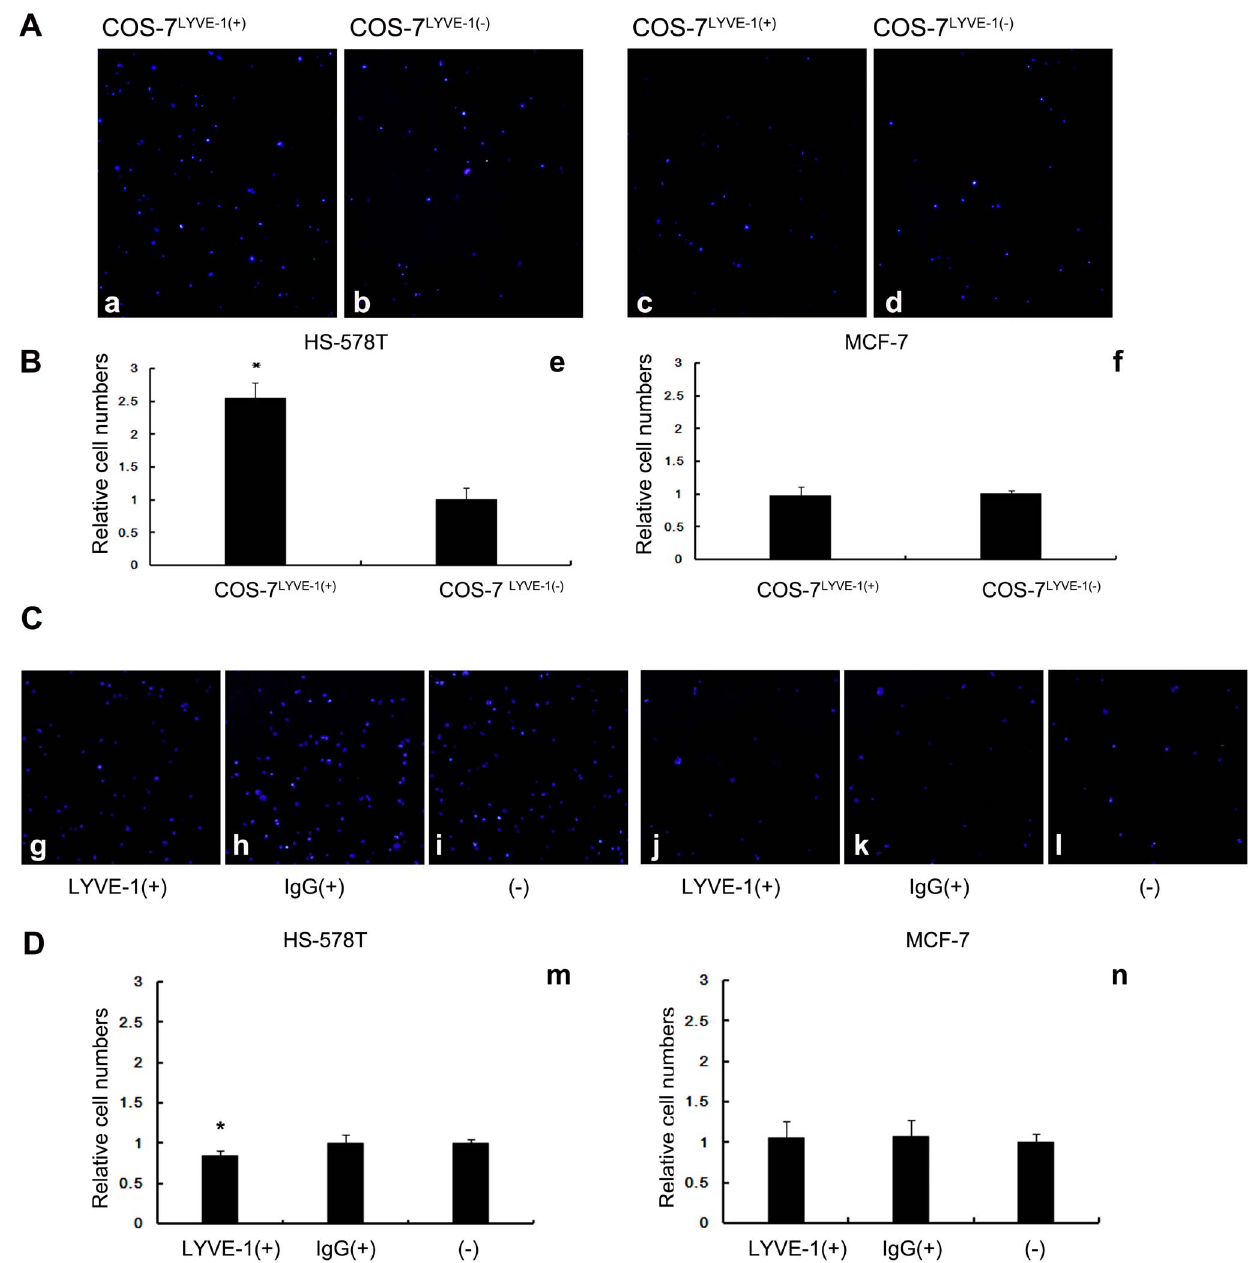
Figure 2. Breast tumor cells expressing high or low levels of HA adhere differently to cells under static conditions. (A) Adhered HS- 578T and MCF-7 cells appear as blue spheres (a–d). DAPI-labeled HS-578T cells were more adherent to the confluent monolayer of COS-7 LYVE-1( + ) cells compared with COS-7 LYVE-1( 2 ) . MCF-7 cells adhered similarly with both COS-7 LYVE-1( + ) and COS-7 LYVE-1( 2 ) cells. (B) Quantitative evaluations of HS-578T and MCF-7 cell adhesion on the monolayer of COS-7 cells are shown, and each assay was performed in triplicate. The results are shown as the mean 6 SD of triplicate wells from a typical experiment and are expressed as a fold increase relative to COS-7 cells transfected with the control vector pEGFP-N1. *P , 0.05 versus indicates transfected pEGFP-N1 vector control COS-7 cells. (C) Adhered HS-578T and MCF-7 cells appear as blue spheres (g–l). DAPI-labeled HS-578T cells were adherent to the confluent monolayer of SVEC4-10 cells before and after blocking with LYVE-1 antibody, isotype antibody. (D) Quantitative evaluations of the data from HS-578T and MCF-7 cell adhesion on the monolayer of SVEC4-10 cells are shown, and each assay was performed in triplicate. The results are shown as the mean 6 SD of triplicate wells from a typical experiment and are expressed as a fold decrease relative to SVEC4-10 cells without treatment. *P , 0.05 versus SVEC4-10 cells without treatment. interaction influences tumor lymph metastasis, we examined the hyaluronan, which was previously reported [16]. However, adhesive ability of tumor cells (different HA content) to LYVE-1- whether low HA content in tumor cells produces an interaction with LYVE-1 through other factors to influence tumor cell positive cells. Our static adhesion assay revealed that LYVE-1 enhances the adhesion of HS-578T cells to COS-7 cells via adhesion is still unclear. We also performed a static adhesion